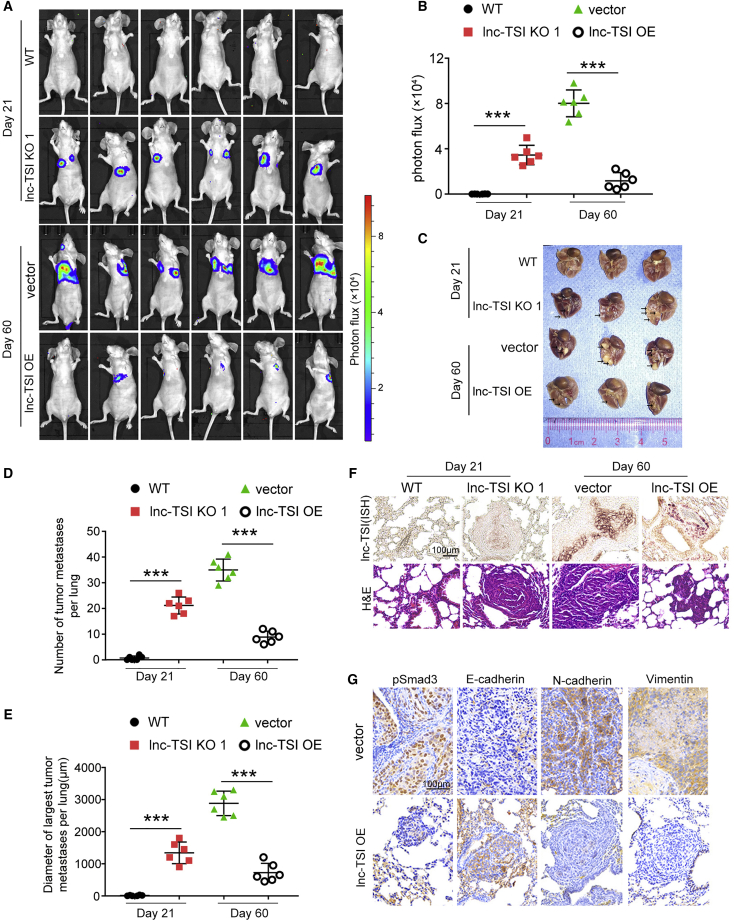
lnc-TSI Inhibited Cancer Metastasis in the Lung Metastasis Model of Nude Mice(A) Images showed the bioluminescent signal intensities of each BALB/C nude mouse after tail vein injection of Caki-1 cells treated with lnc-TSI knockout or overexpression. (B) Quantification of bioluminescent imaging signal intensities. (C) Pulmonary metastases in BALB/C nude mice after tail vein injection of Caki-1 cells treated with lnc-TSI knockout or overexpression. The arrows indicate the tumor metastases in lung. (D and E) The number (D) and the diameter (E) of the metastases in lung are shown. (F) Representative images of H&E staining and in situ hybridization of lnc-TSI in the lung from nude mice injected with Caki-1 cells treated with lnc-TSI knockout or overexpression. (G) Immunohistochemistry assays showed that overexpression of lnc-TSI inhibited EMT. ∗∗∗p < 0.001 (n = 6 for each group).